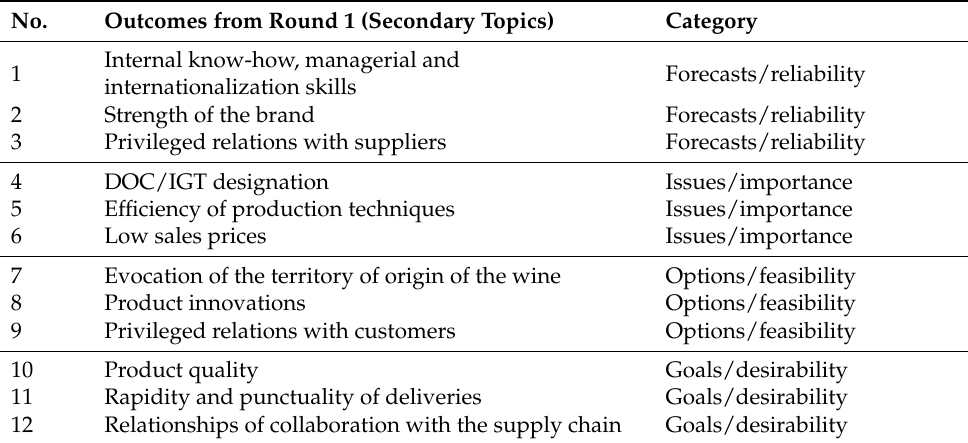
Table 4. Outcomes and categories for the items combined by respondents during round